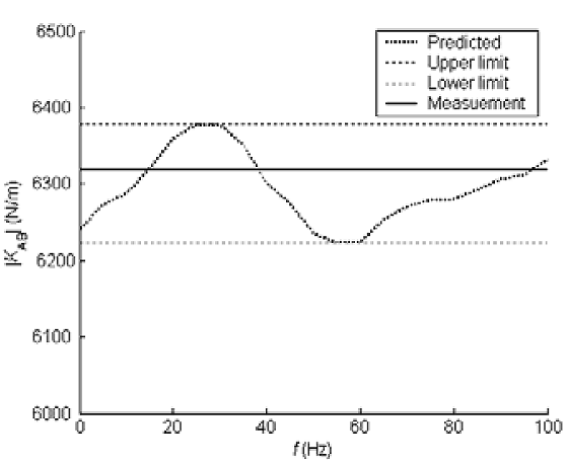
Fig. 12. Comparison of predicted and measured component level FRF (- - - -, predicted; —,